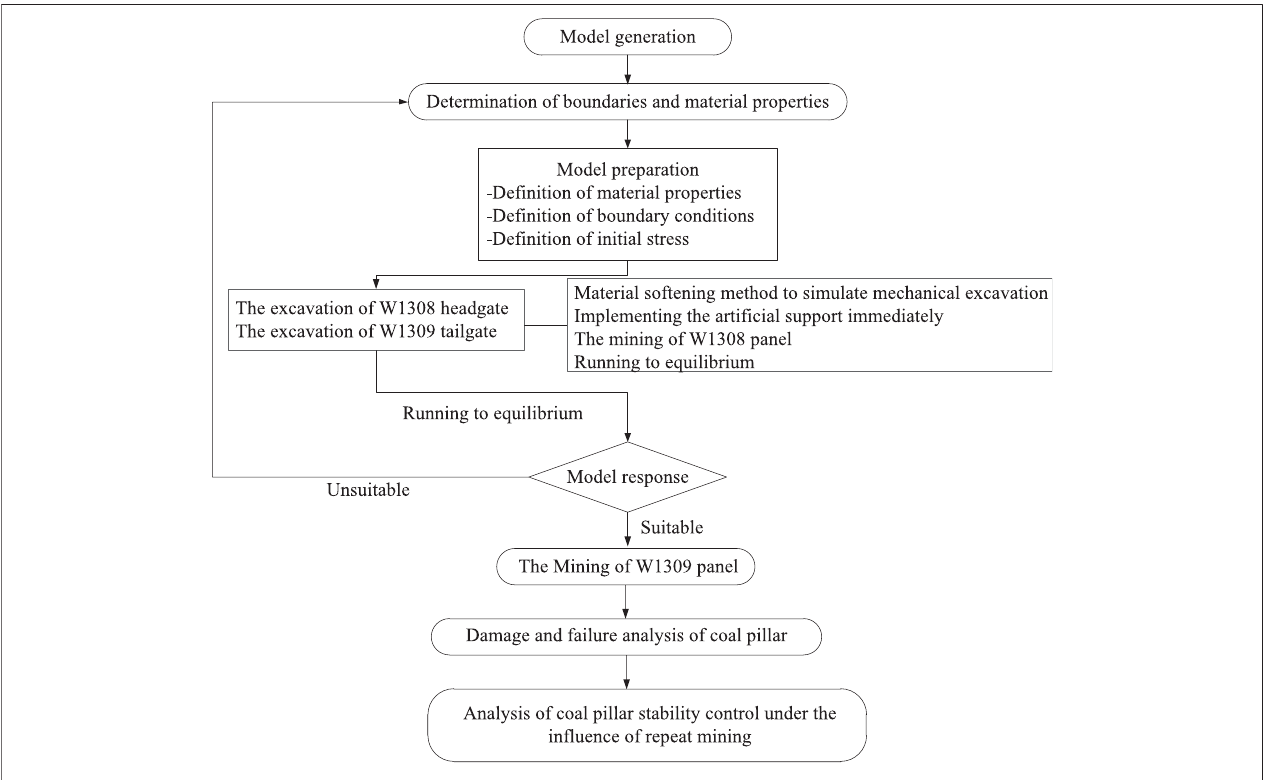
FIGURE 5 | Flowchart of numerical modeling for studying coal pillar